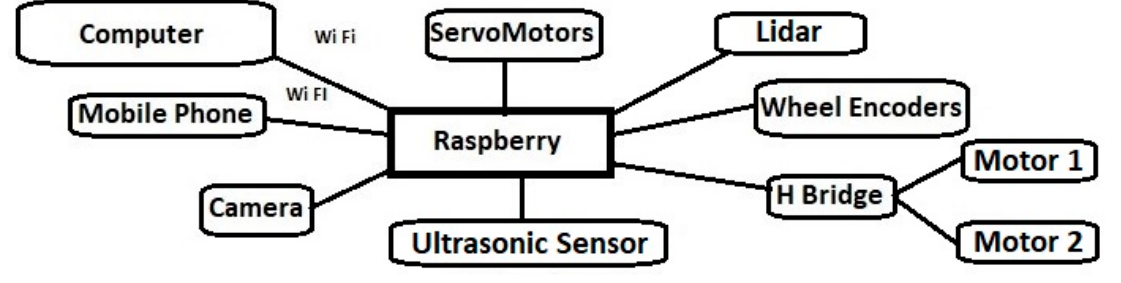
Figure 3. EUROPA control